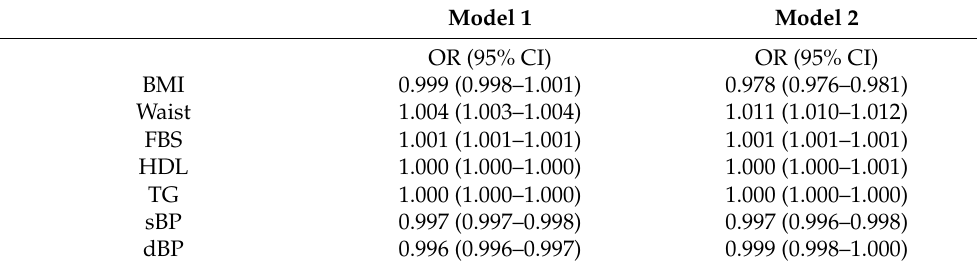
Table 5. Relationship between metabolic syndrome factors and incident depression (men).